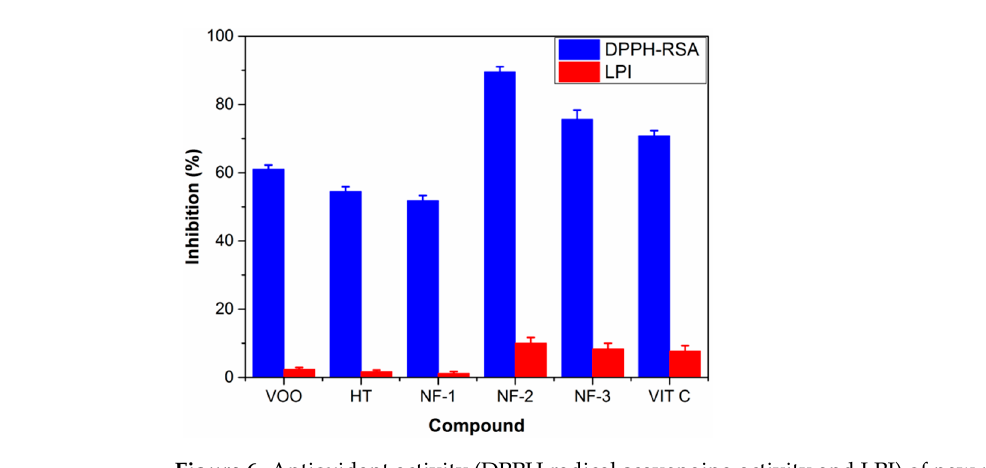
Figure 6. Antioxidant activity (DPPH radical scavenging activity and LPI) of new nanoformulations and their native